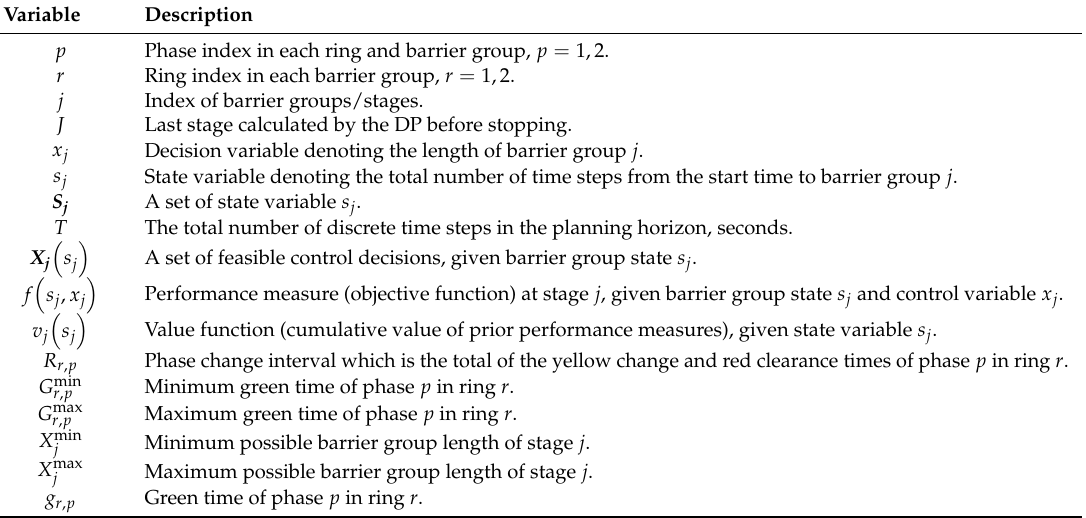
Figure 2. The relationship between the states, decisions, and the total number of discrete time-steps. Table 1. Notation of key parameters and variables used in the dynamic programing (DP) algorithm.